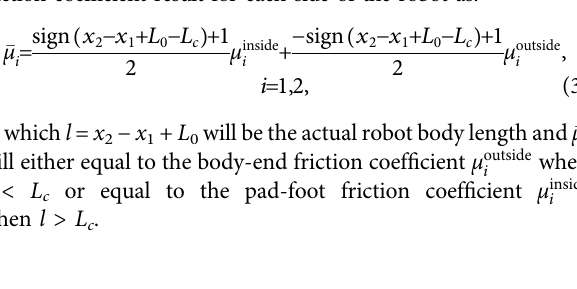
FIGURE 4 | Steady-state locomotion velocities show the simulation results under different actuation magnitudes and frequencies. (A) Locomotion with only direction-based friction force and (B) Locomotion with a compound friction